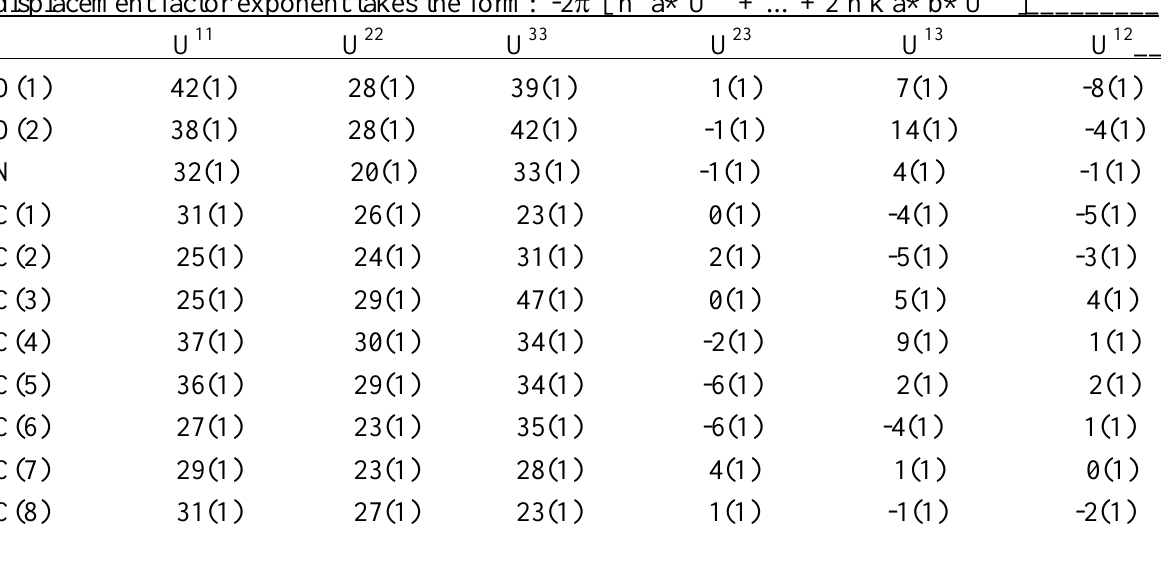
Table 5. Anisotropic displacement parameters (Å2x 103) for eb1a. The anisotropic displacement factor exponent takes the form: -2 π 2 [ h 2 a* 2 U 11 + ... + 2 h k a* b* U 12 ]_________